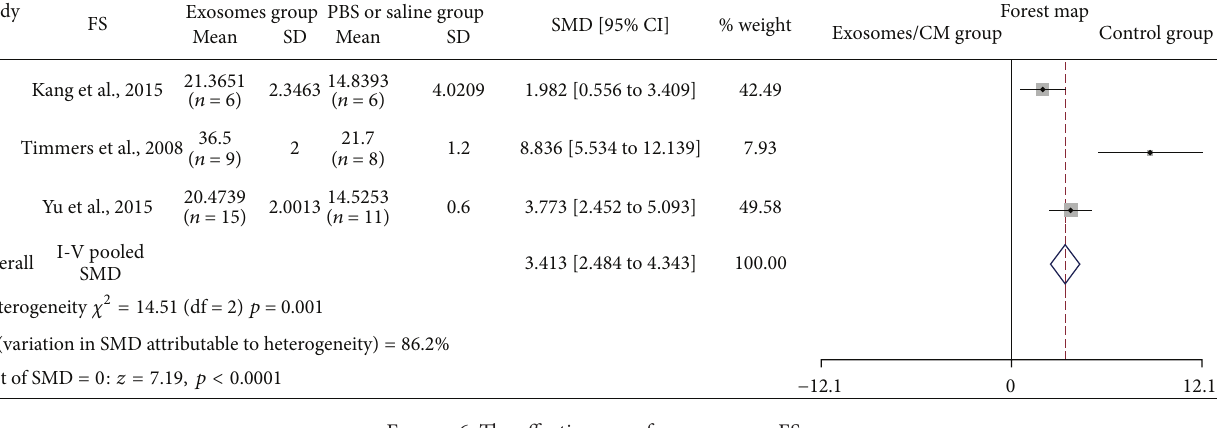
Figure 6: The effectiveness of exosomes on FS.